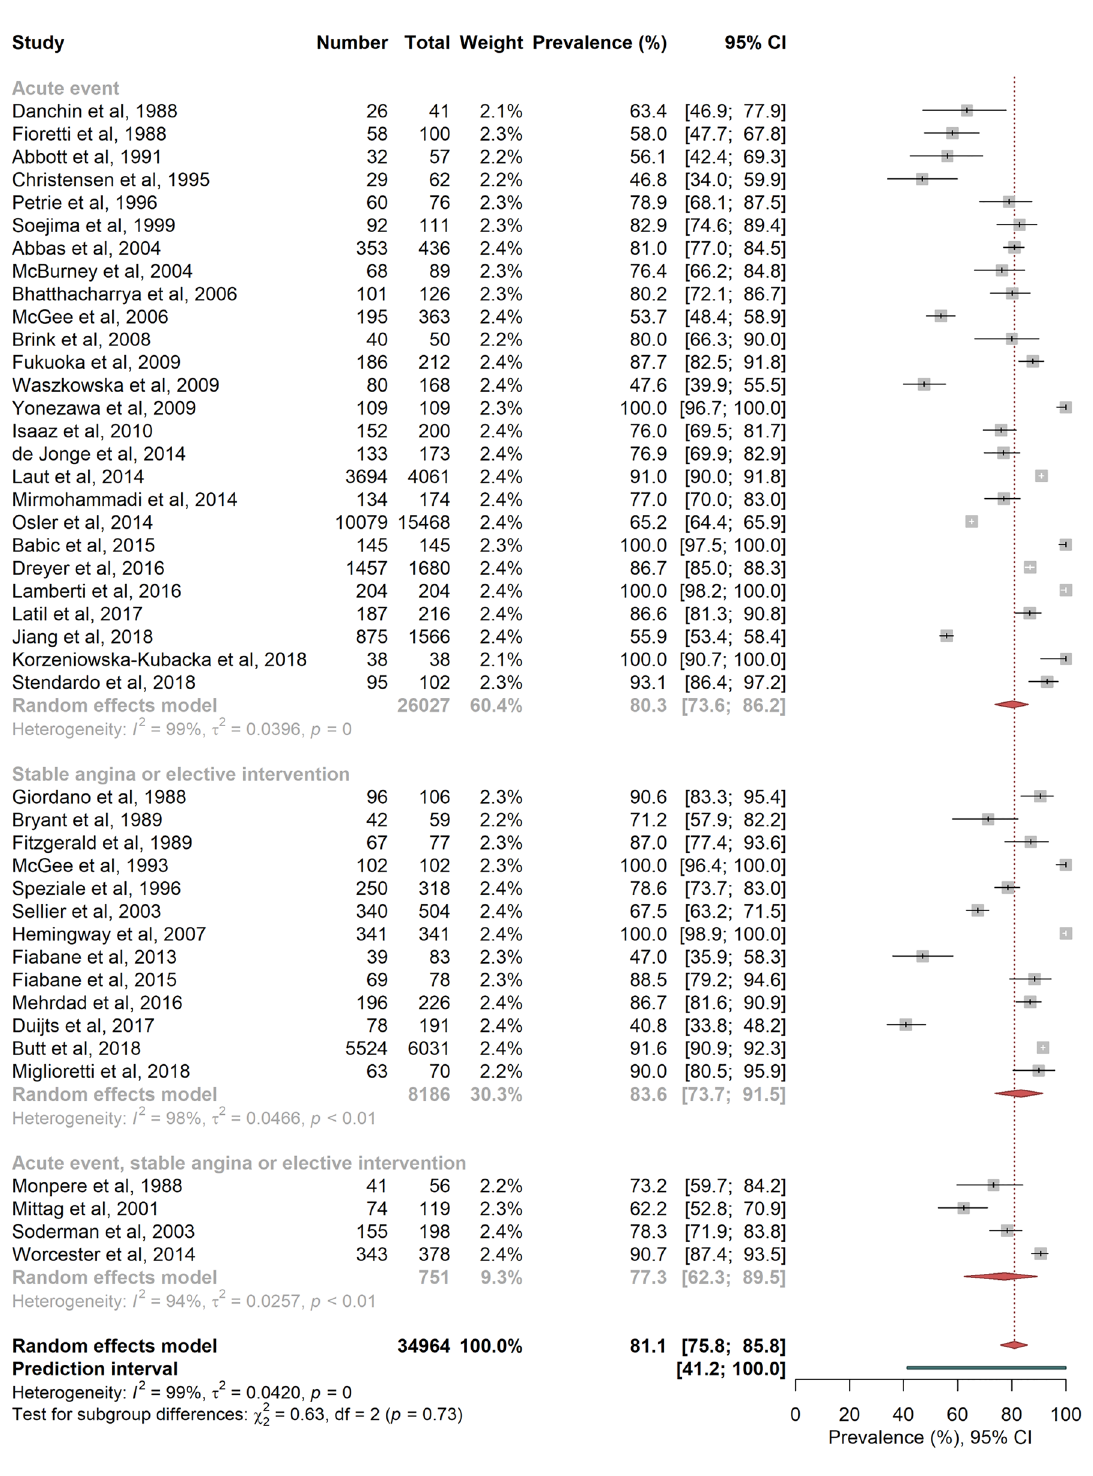
Figure 2. Random-effects meta-analysis of return-to-work prevalence according to the type of events. The squares and horizontal lines correspond to the study-specific prevalence and 95% CIs. Proportionally sized boxes represent the weight of each study. The diamond represents the pooled prevalence and 95% CI of the overall population. The horizontal thick line corresponds to the 95% prediction